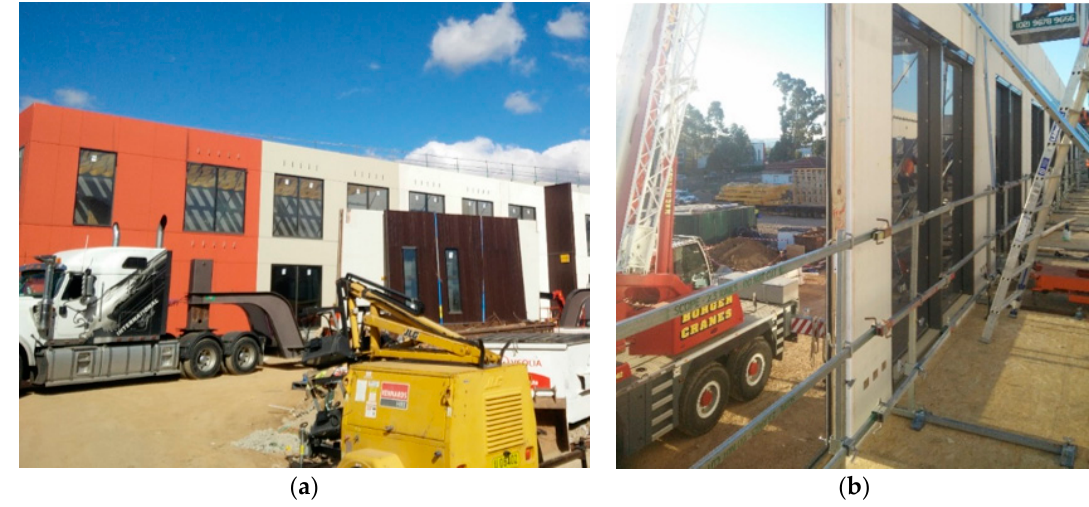
Figure 16. Implementation with panelised form of prefabricated construction: ( a ) Commercial office building using the gasket seals; ( b ) EPDM gasket seal positions on the wall towards the outside face. The completed prefabricated wall panels are lifted and place into position whilst compressing the rubber gasket as shown in Figure 17a. The sealed joint after the completed lift and installation of the panel is shown Figure 17b.